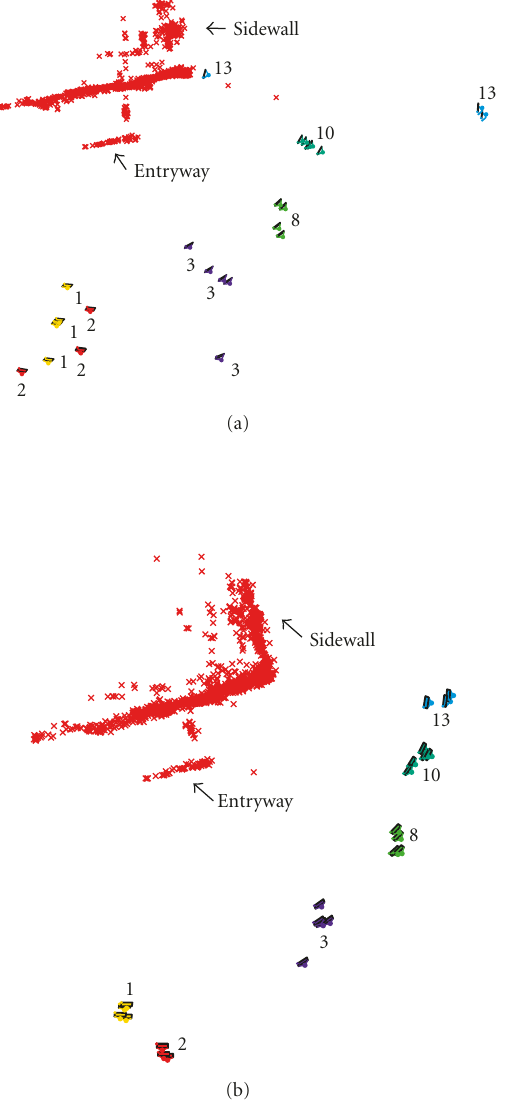
Figure 7: Multiple camera estimates of a subset of cameras (a) be- fore and (b) after belief propagation. The numbers correspond to the node numbers in Figures 5 and